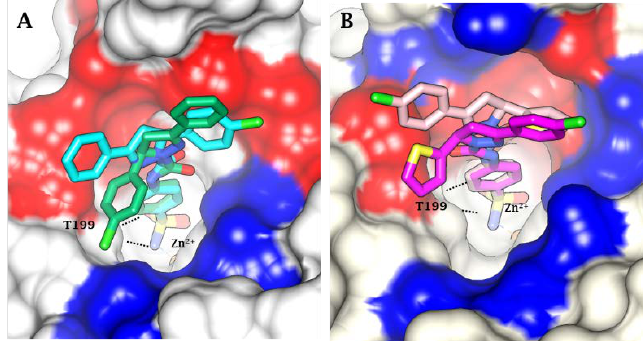
Figure 2. Surface representation of ( A ) CA IX (pdb 5FL4) bound to (R) -6 (green) and (S) -6 (cyan) and ( B ) CA XII (pdb 1JD0) bound to (R) -18 (magenta) and (S) -18 (pink). Lipophilic and hydrophilic residues are colored red and blue, respectively.